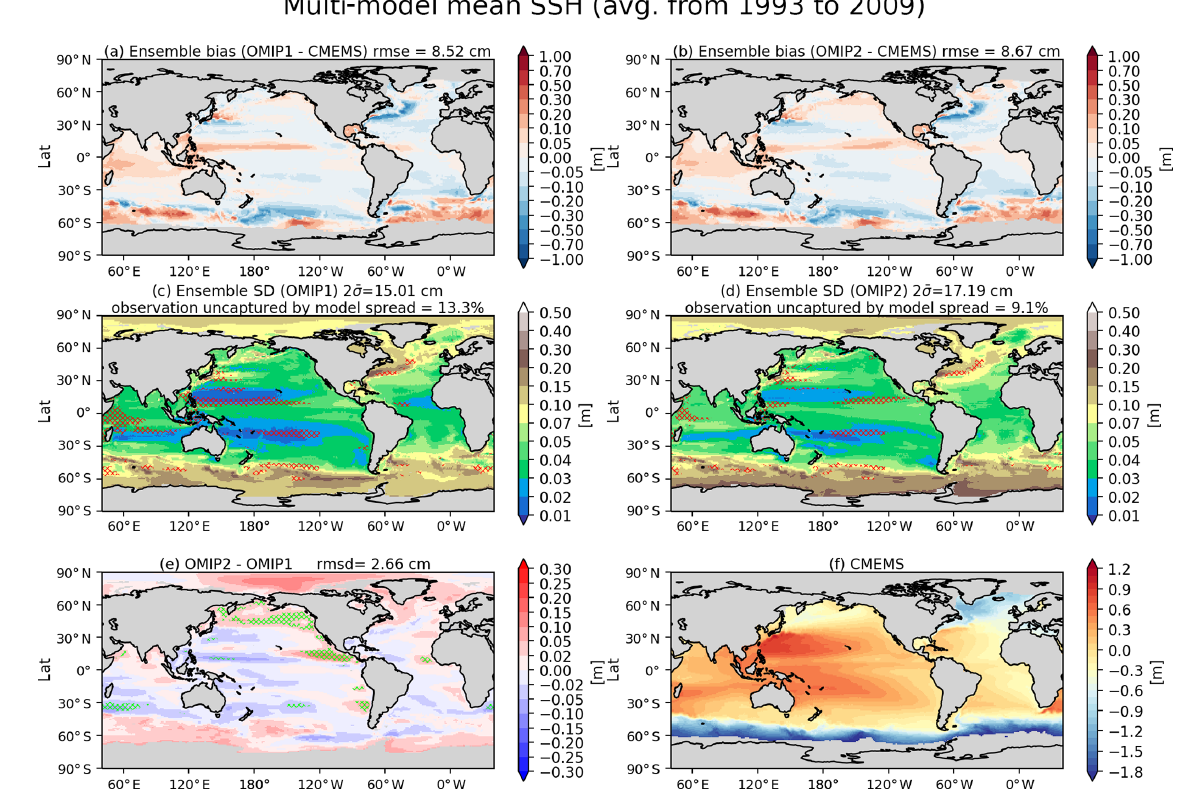
Figure 10. Evaluation of simulated sea surface height (m). Panels (a) and (b) show the bias of the multi-model mean, 17-year (1993–2009) mean SSH relative to the Copernicus Marine Environment Monitoring Service (CMEMS). (a) OMIP-1 and (b) OMIP-2. The middle two panels show the standard deviation of the ensemble, with the regions where the observation is outside the 95% confidence range of the model spread ( ± 2 σ ) hatched with red. (c) OMIP-1 and (d) OMIP-2. (e) Difference between OMIP-1 and OMIP-2 (OMIP-2 minus OMIP-1), with the regions where the difference is significant at 95% confidence level hatched with green as in Fig. 6. (f) Annual mean SSH of CMEMS. Note that all SSH fields are offset by subtracting their respective quasi-global mean values before evaluation as described in Appendix C. At the top of each panel, global mean values are depicted as in Fig. 6. See Figs. S24–S26 for results of individual